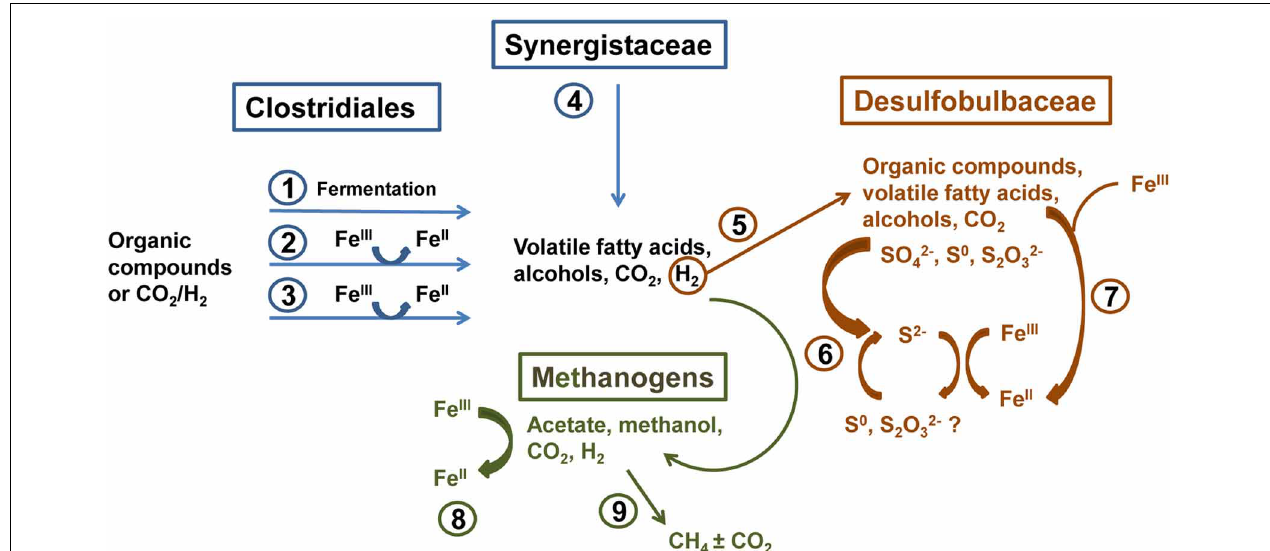
FIGURE 7 | Proposed biogeochemical reduction of Fe III and cycling of S in amended MFT, based on enrichment of Clostridiales, Synergistaceae, and Desulfobulbaceae in amended MFT as revealed by 16S rRNA gene pyrosequencing (Figure 6). (1) Clostridiales ferment organic substrates yielding fatty acids, alcohols, CO 2 , and H 2 . (2) Fermentative metabolism can divert a proportion of electron flow to Fe III reduction without conserving energy for growth (Coleman et al., 1993; Dobbin et al., 1999). (3) Some Clostridia reduce Fe III through respiration (dissimilatory reduction) to support growth (Slobodkin et al., 1999; Kunapuli et al., 2007). (4) Synergistaceae ferment organic substrates (Zavarzina et al., 2000). (5) H 2 produced by